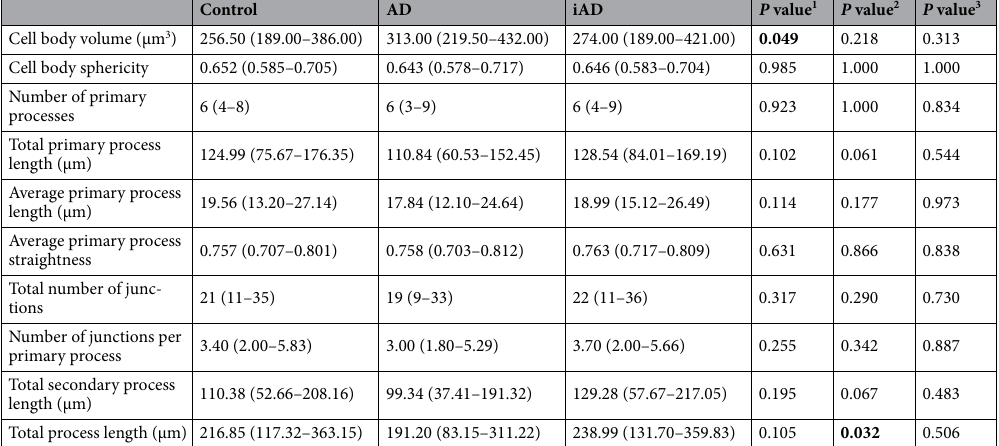
Table 2. 3D morphological features of microglia in controls AD and immunised AD cases. Values are median with IQR. P value by Kruskal–Wallis test with Benjamini–Hochberg correction for multiple testing. P value 1 : control vs AD; P value 2 : AD vs iAD. P value 3 : Control vs iAD. Significant P value in